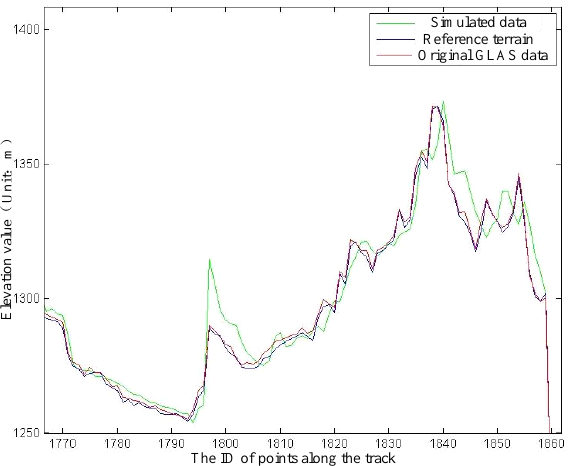
Figure 5. The profile of original GLAS data, reference terrain and simulated data derived from pointing error Figure 4. The distribution of GLAS laser footprint points During the experiment, the GLAS laser pointing angle in the X and Y axes is simulated to add 10 ", 20", 30 ", 50", 70 "and 120" error. And the orbit height of ICESat is about 600km, then 1" pointing angle deviation can cause about 2.9m error on the ground, so the positioning error caused by the simulated angle error can be approximately to 30m~360m. At the same time, the pointing angle error will cause the elevation error, as shown in Figure 5, the original GLAS data is the red curve, the blue represents the terrain data, and the green represents the GLAS Table 1. Simulated GLAS laser pointing angle calculation based on terrain matching